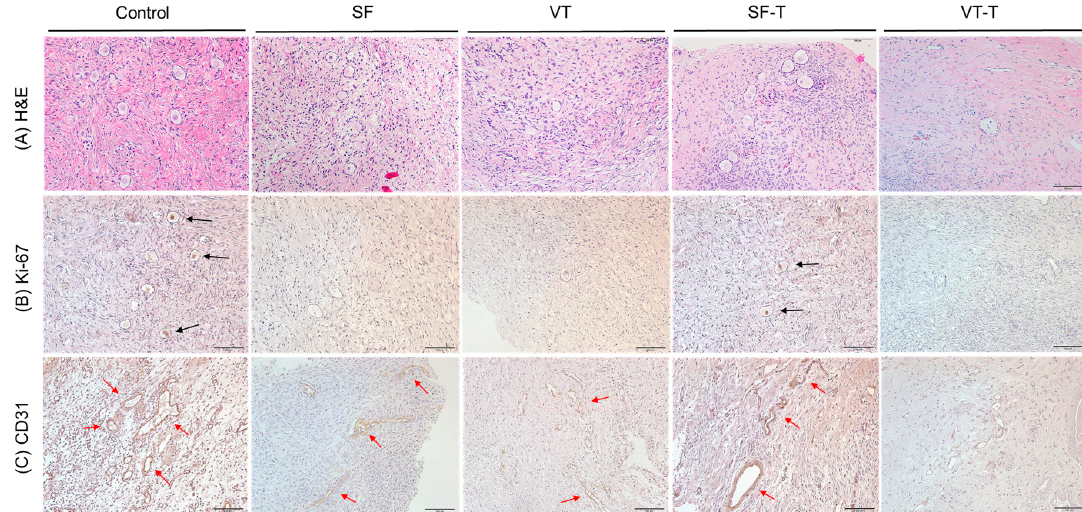
Figure 3. Histopathological findings of the human ovarian tissues after cryopreservation and xenotransplantation. ( A ) Hematoxylin and eosin staining (H&E) of human ovarian tissues in the five groups. ( B ) Histological features of human ovarian tissues in the five groups evaluated with immunohistochemistry staining for Ki-67, a marker of cell proliferation. Black arrows indicate the cells stained with Ki-67. ( C ) Histological features of human ovarian tissues in the five groups evaluated with immunohistochemistry staining for CD31, a marker of angiogenesis. Red arrows indicate the cells stained with CD31. Original magnification ×200. Abbreviations: SF, cryopreserved with slow freezing technique and thawed group; VT, cryopreserved with vitrification technique and thawed group; SF-T, the group xenotransplanted after slow freezing and thawing; VT-T, the group xenotransplanted after vitrification and thawing.